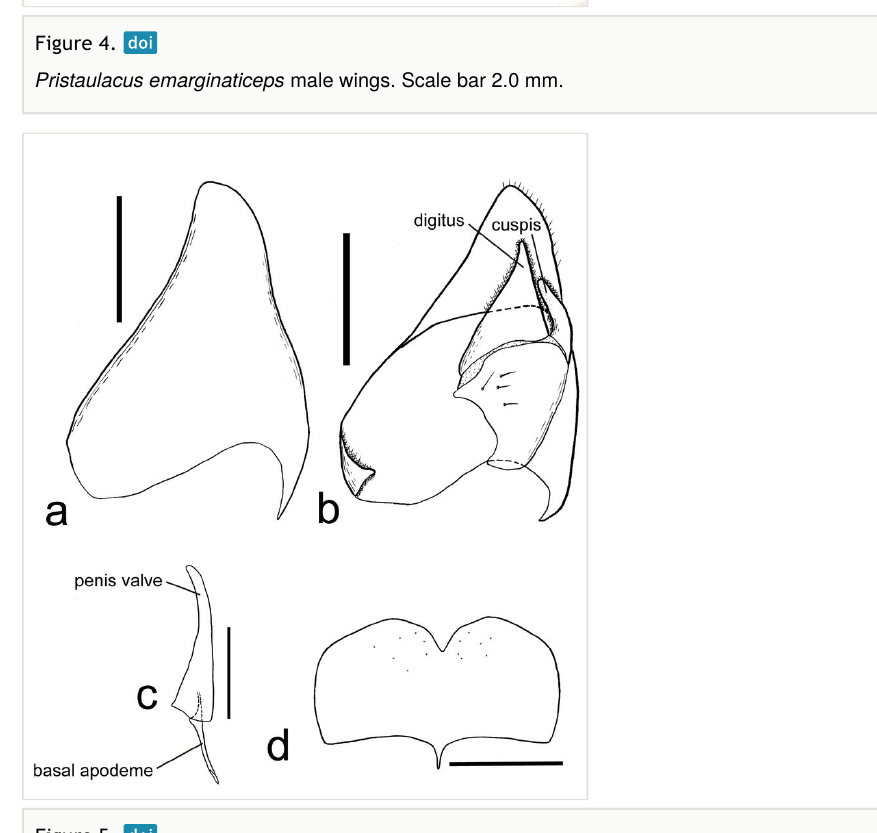
Figure 5. Pristaulacus emarginaticeps male genitalia. Scale bars 0.5 mm. a : lateral view of left paramere, setae omitted; b : mesal view of right paramere; c : aedeagus, lateral view; d : subgenital plate. (Terminologies of genitalia are shown in black letters,